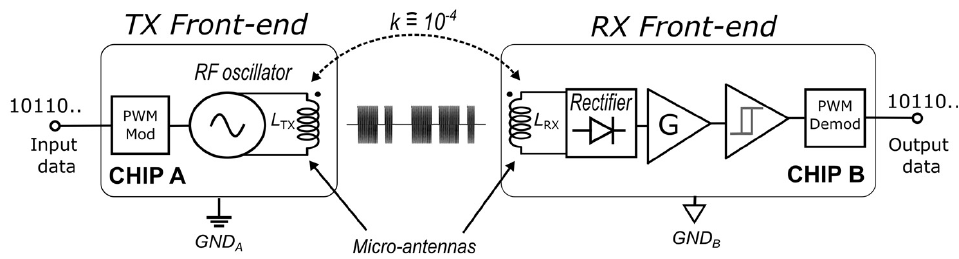
Figure 3. Simplified block-diagram of galvanic isolator based on RF coupling (single physical chan- nel).